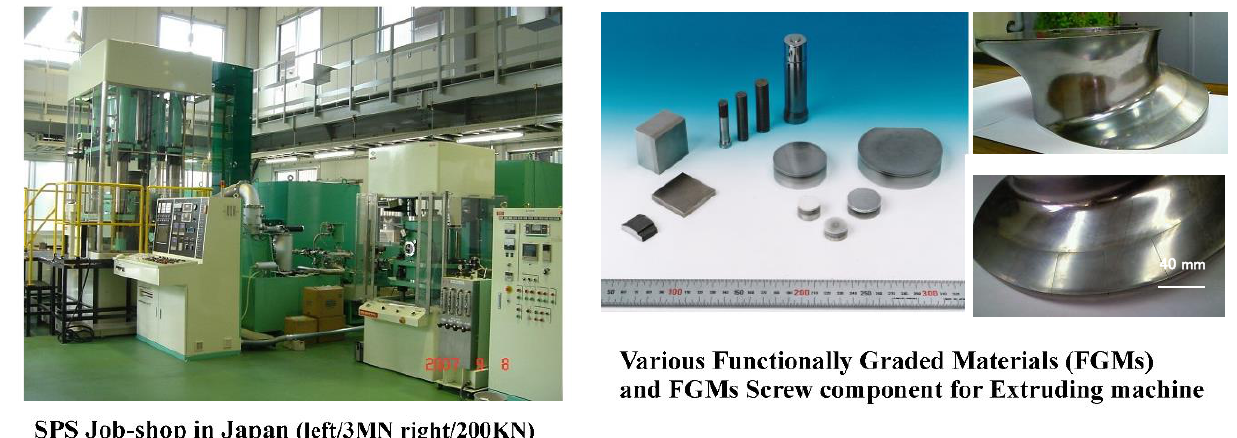
Figure 4. Example of SPS job-shop center in Japan and SPSed compact.